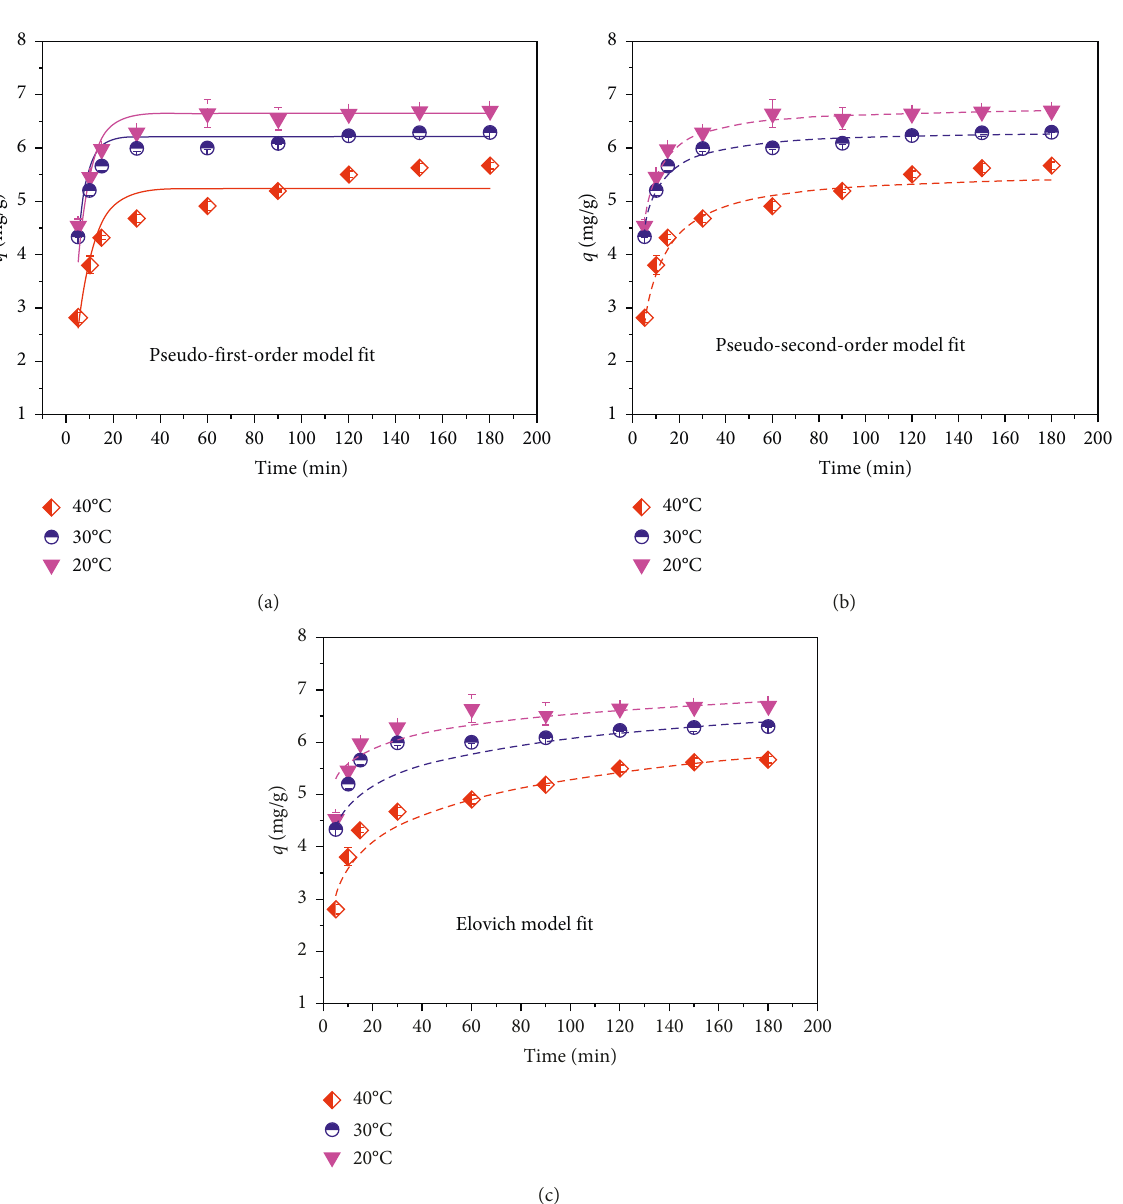
Figure 6: Effect of the contact time on Cr(VI) adsorption onto FSS at various temperatures; pH 2; 10mg/L of initial Cr(VI); 4 g/L of adsorbent dosage. Table 2: The calculated kinetic parameters of Cr(VI) adsorption onto FSS of models at various temperatures. Unit Pseudo-first-order